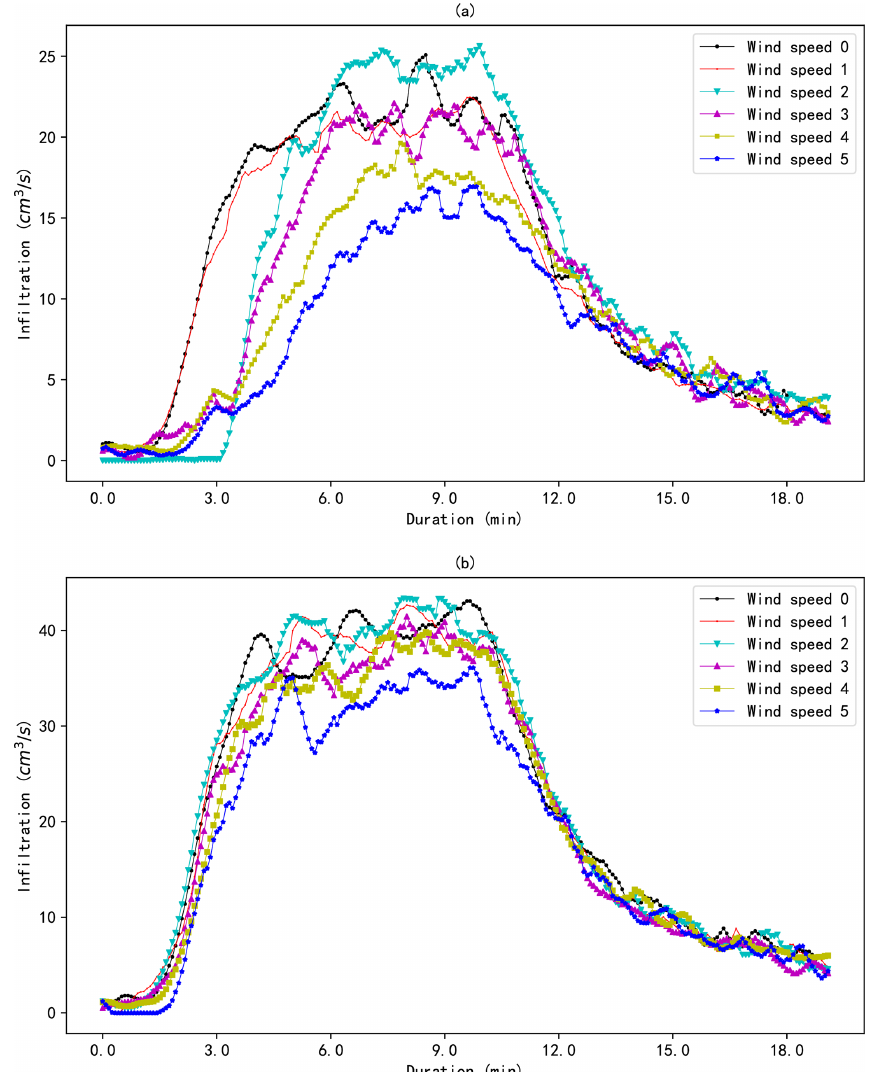
Figure 5. The hydrographs of the infiltration of the scale model for different wind speeds under rainfall types 1 (a) and 2 (b)